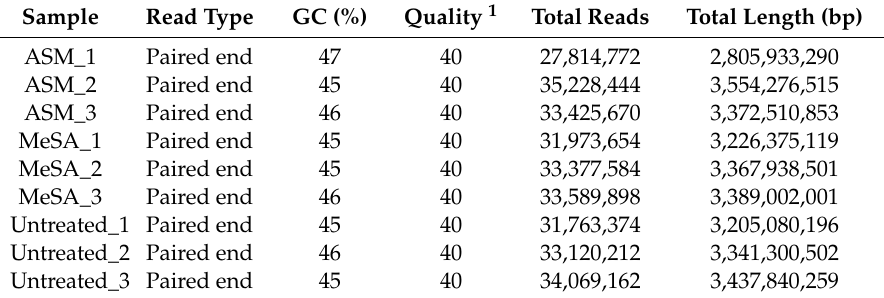
Table 1. Detailed information of the RNA-seq